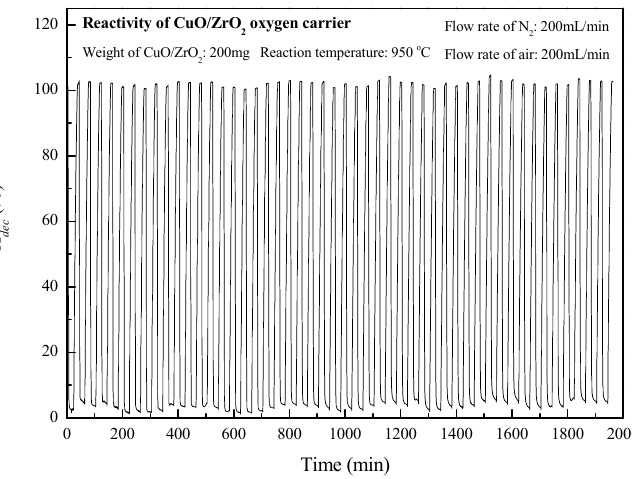
Figure 4. Conversion for oxygen uncoupling of CZ230-S1 in the TGA under nitrogen atmosphere at 950 °C.